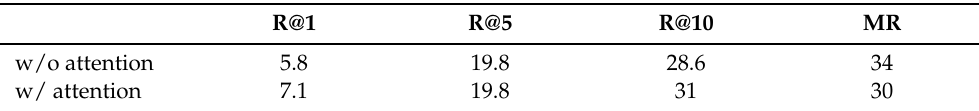
Table 3. Effectiveness of the spatial attention.